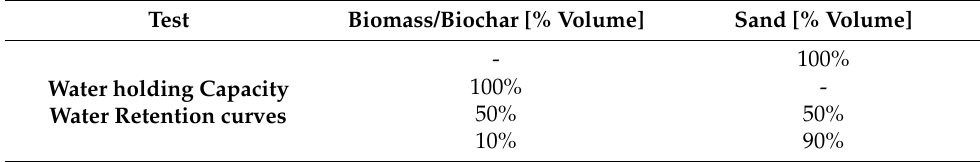
Table 1. Breakdown of the percentages by volume used between biomass/biochar and sand.